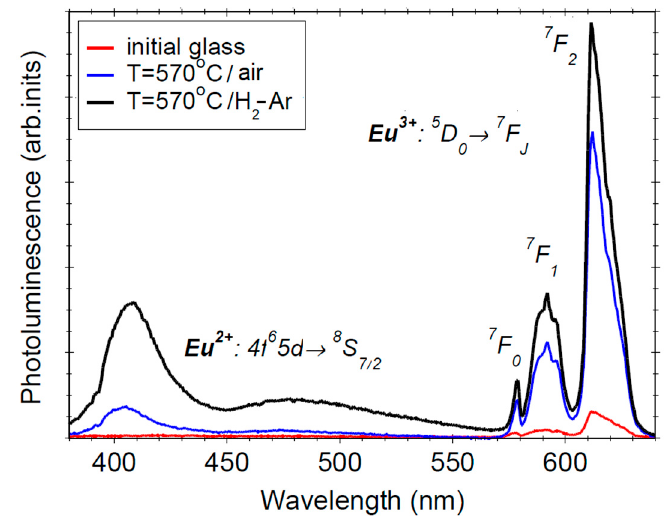
Figure 5. Photoluminescence spectra of the initial Eu-doped chloroborate glass and glass-ceramic